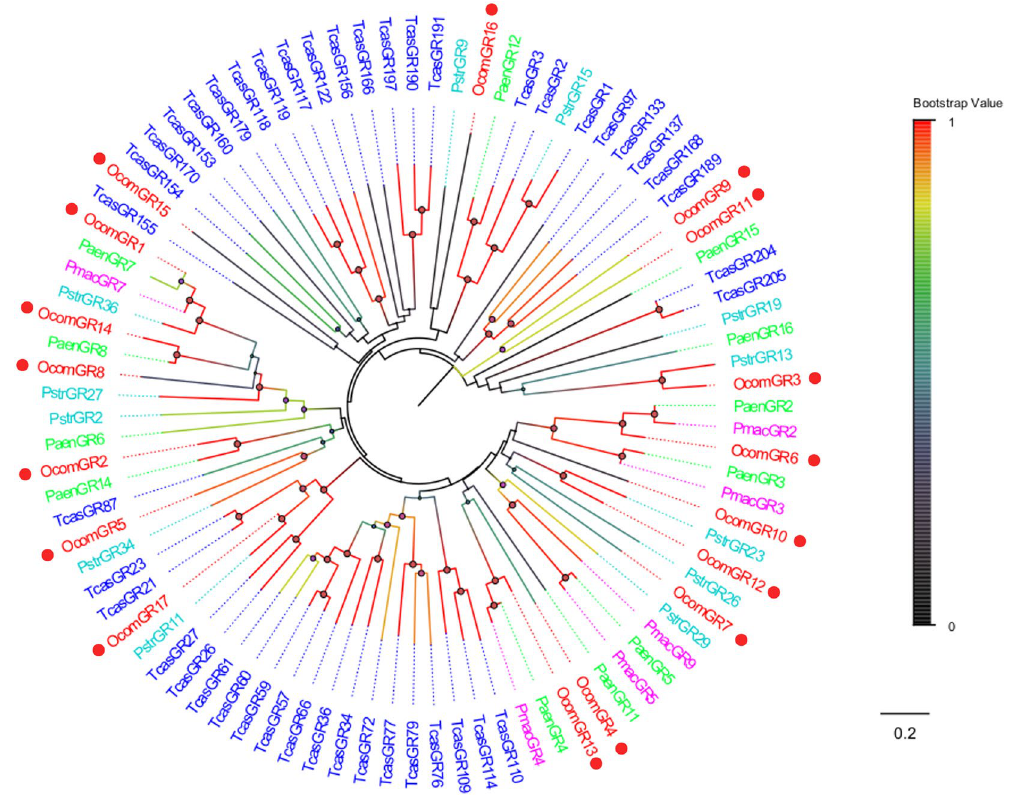
Figure 7. Neighbor joining phylogenetic tree of candidate OcomGRs with known Coleopteran GR sequences. Tcas, Tribolium castaneum (N = 44); Pmac, Pyrrhalta maculicollis (N = 6); Paen, Pyrrhalta aenescens (N = 12); Pstr, Phyllotreta striolata (N = 12). Candidate OcomGRs were indicated by red